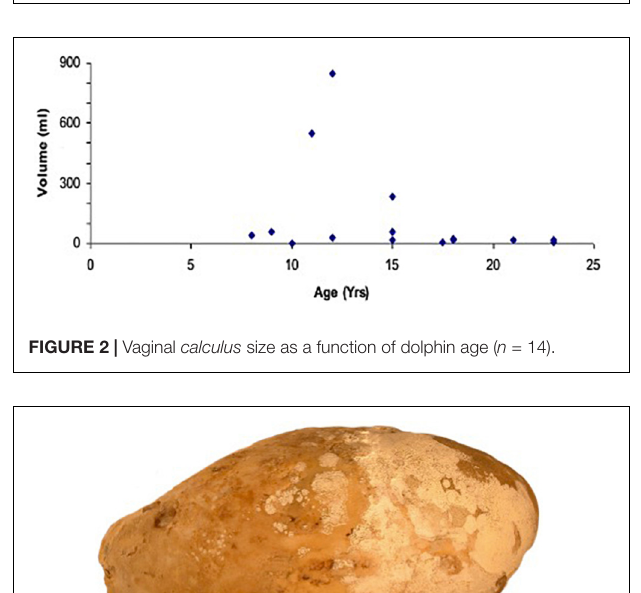
FIGURE 1 | Location map of sampled female common dolphin with vaginal calculi ( n = 14).